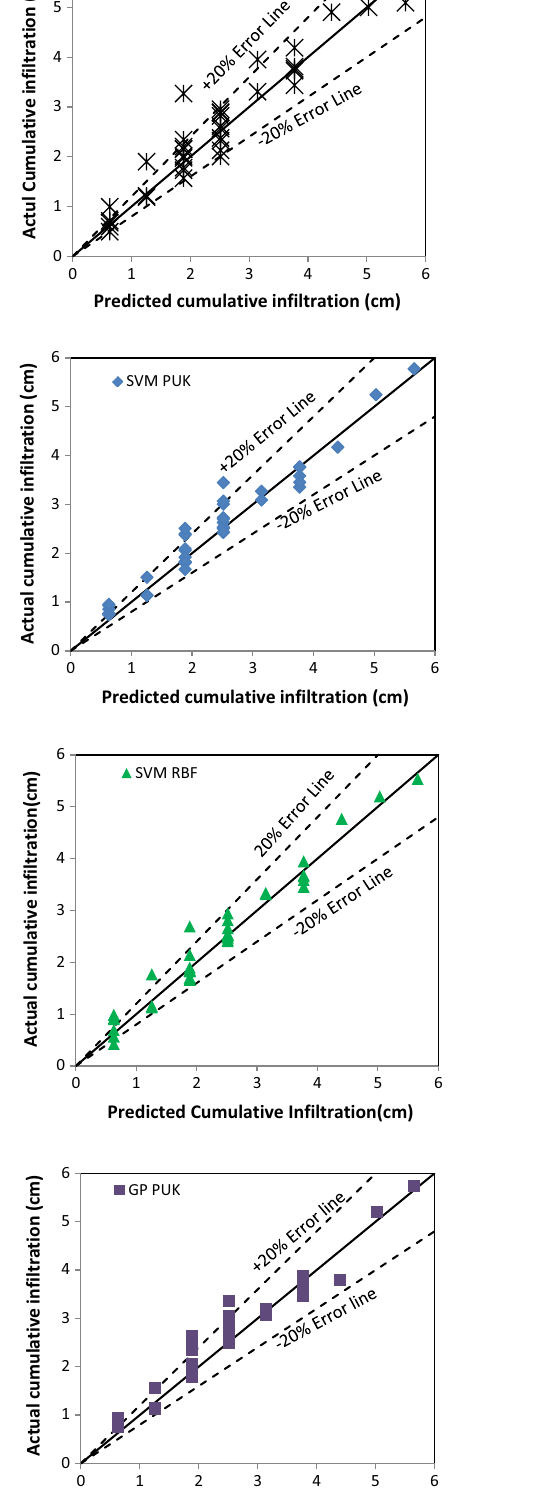
Fig. 8 Actual values versus predicted values using different soft com- puting techniques using testing